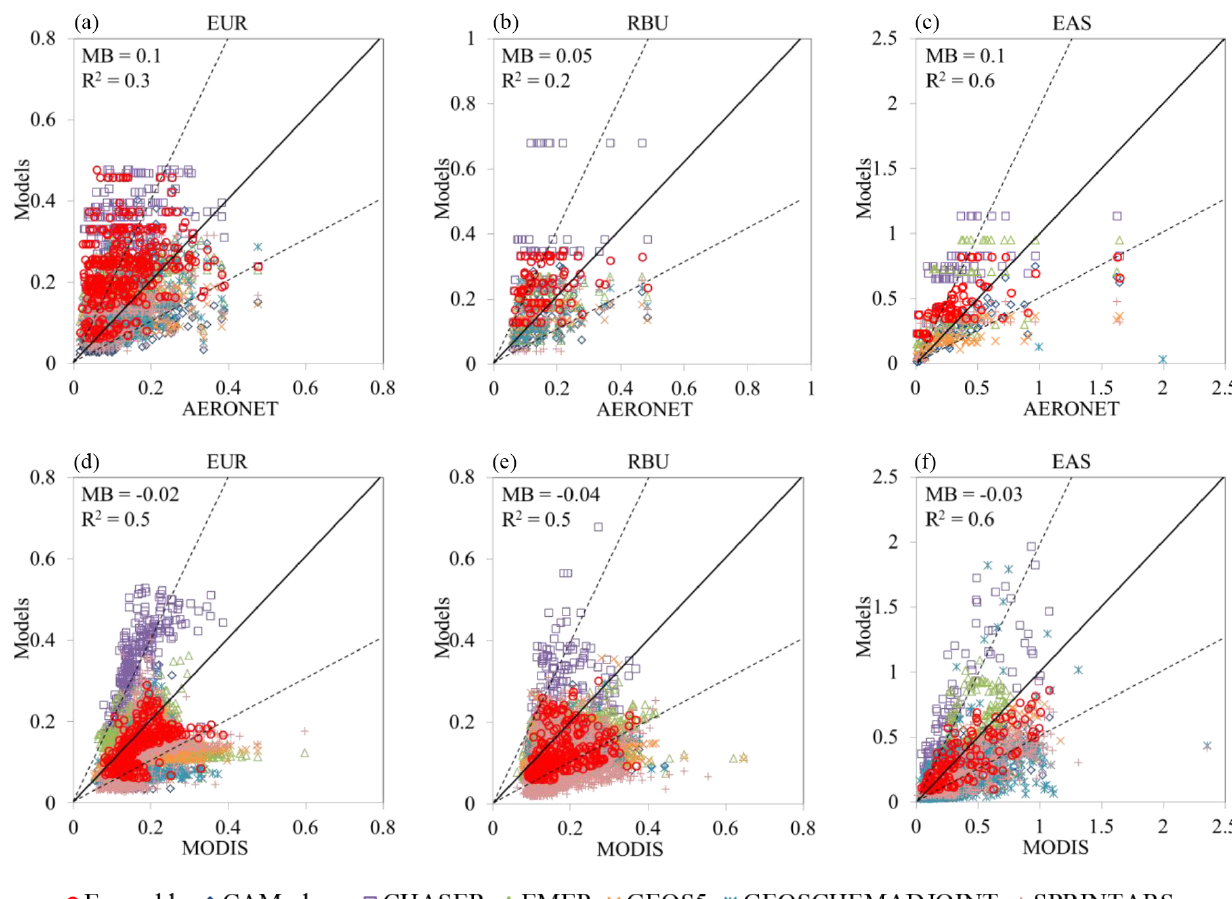
Figure 3. Monthly average AOD comparison between the models and AERONET (a, b, c) and between the models and the MODIS (d, e, f) in EUR (a, d) , RBU (b, e) , and EAS (c, f) . Models are represented by markers with different colors and styles. Evaluation statistics (MB and R 2 ) are indicated for the model ensemble mean in the upper-left corner of the scatter plot. The solid black line is the 1 : 1 line, whereas the black dashed contours represent the 1 : 2 and 2 : 1